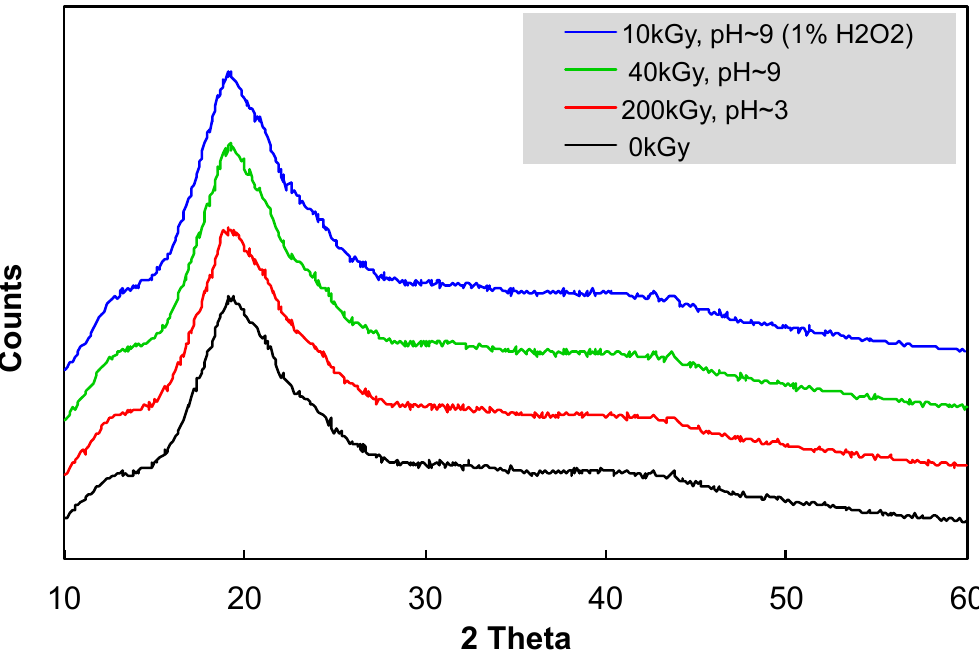
Figure 5. XRD curves of β -glucan samples irradiated at different doses in various pH conditions, with and without the present of H 2 O 2.